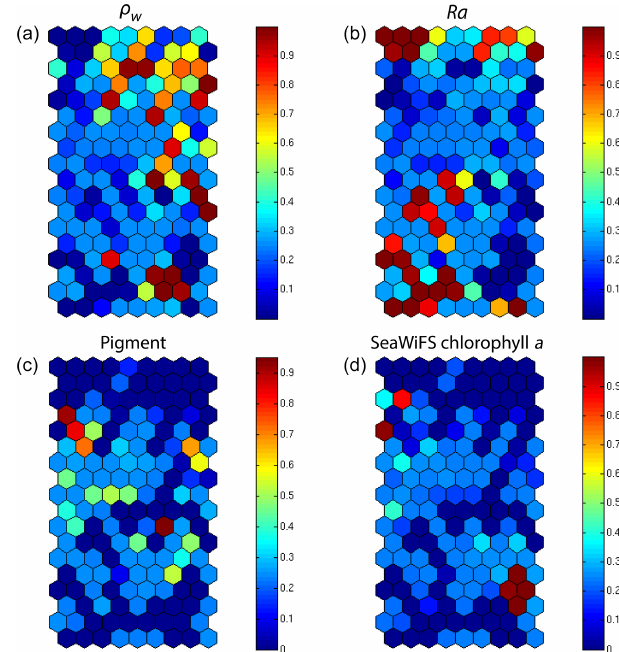
Figure 7. 2S-SOM. Weights ( α cb ) of the four block parameters de- termined at the end of the learning phase; (a) ρ w , (b) Ra, (c) pig- ment, (d) SeaWiFS chl a . The color bars show the percent of the weight estimated by 2S-SOM, with a value of 1 or 0 indicating that the data in the neuron are assembled with respect to that block